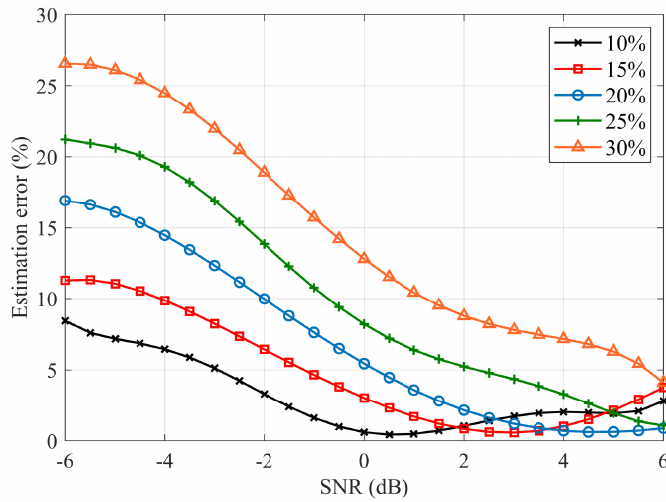
Figure 7. Accuracy of the mean channel occupancy